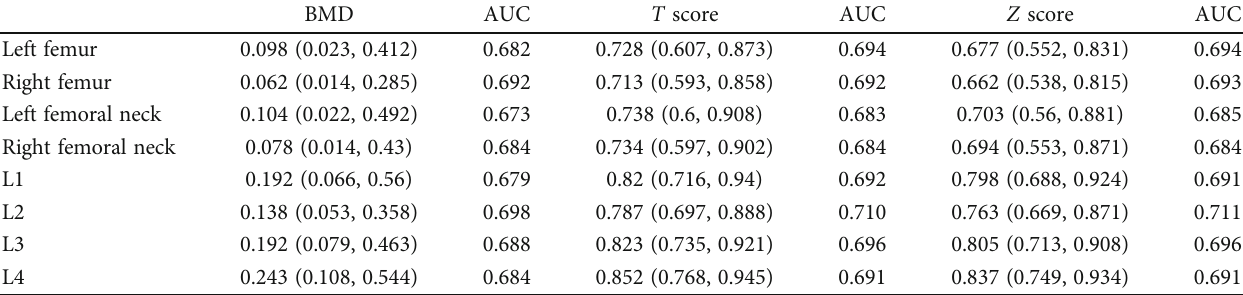
Table 2: Odds ratios of fracture and 95% con fi dence intervals for BMD, T score, and Z score at each level and AUCs of models. Binomial logistic regression models were adjusted for age and sex.